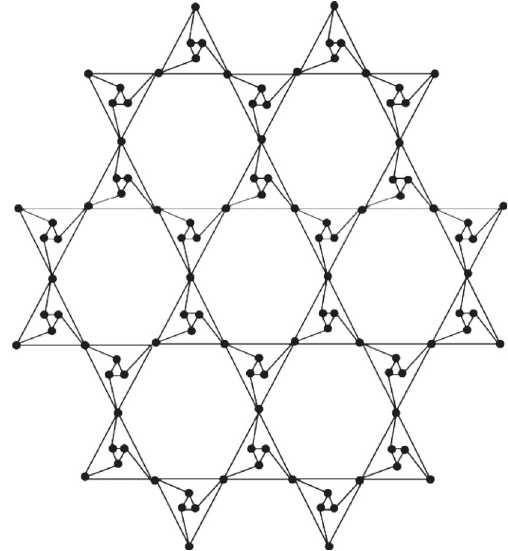
Figure 2: Triangular prism network.